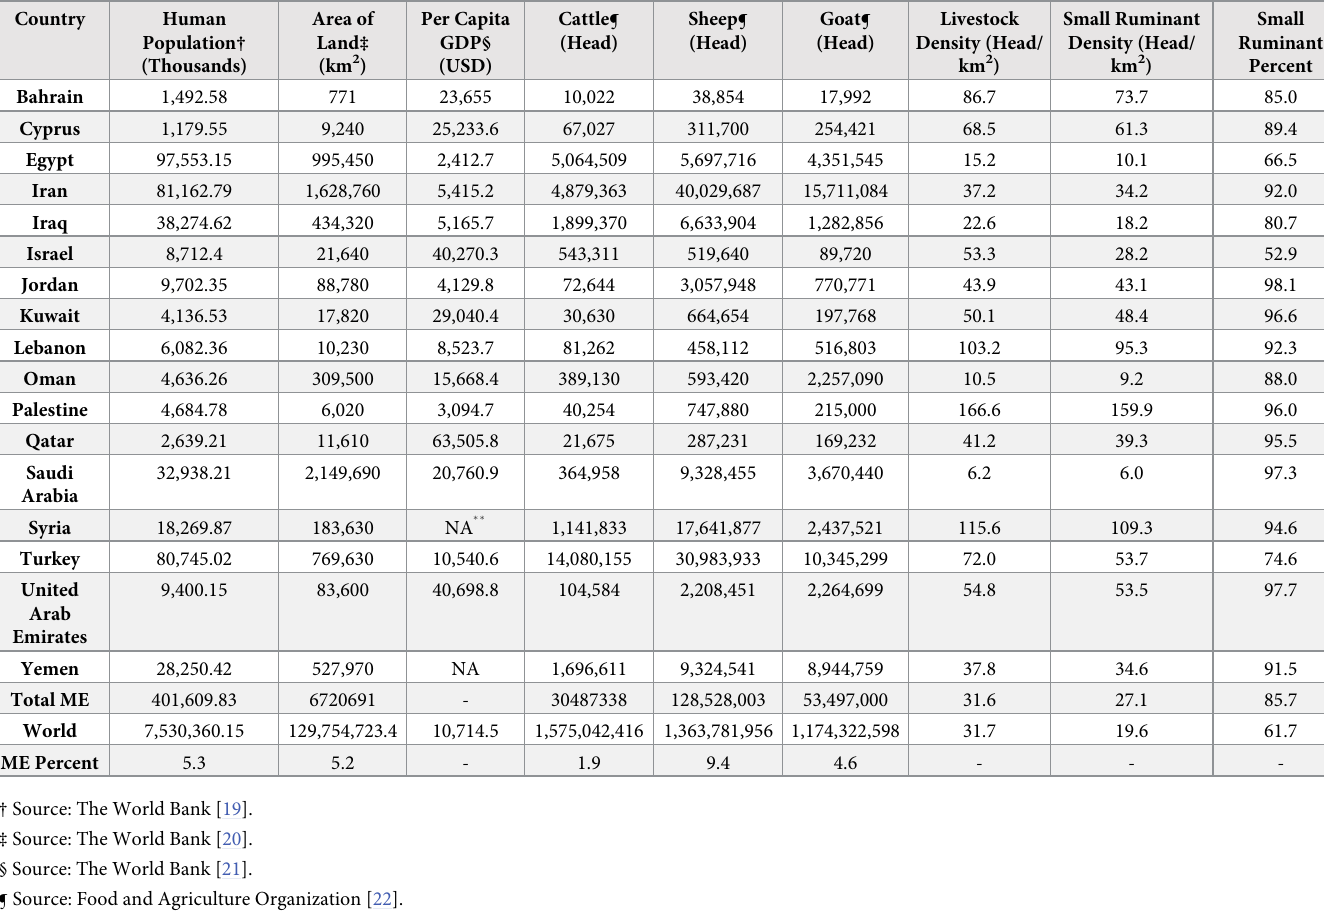
Table 1. Comparative data about human and animal populations, densities, and percentage in the ME